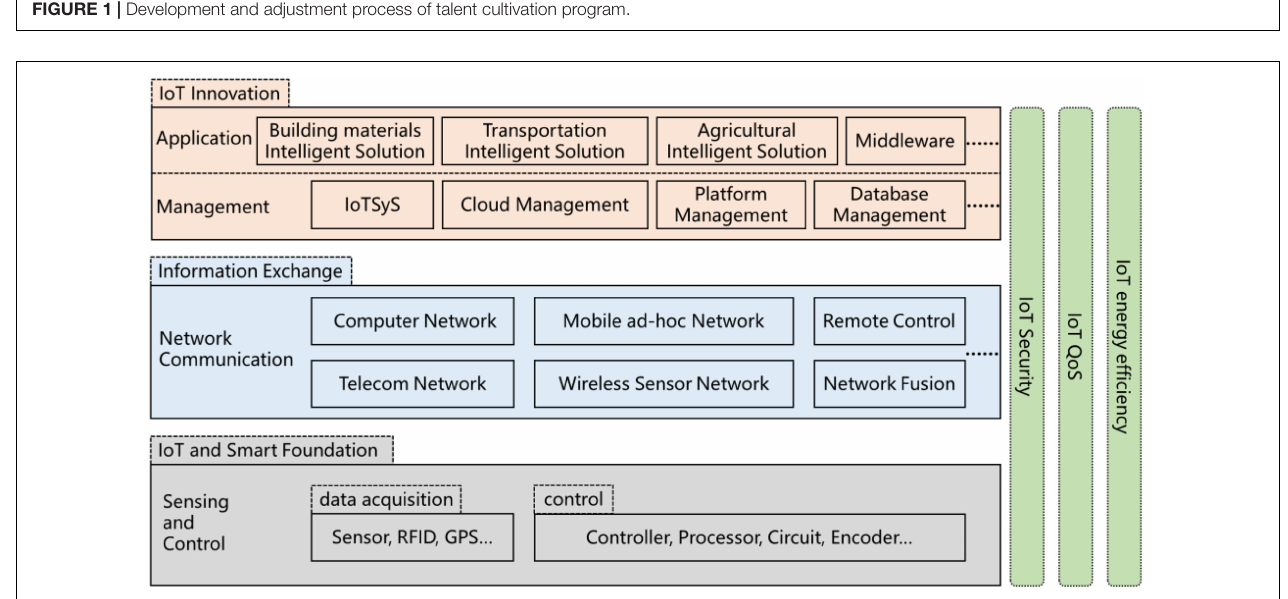
FIGURE 2 | Internet of Things Engineering professional knowledge